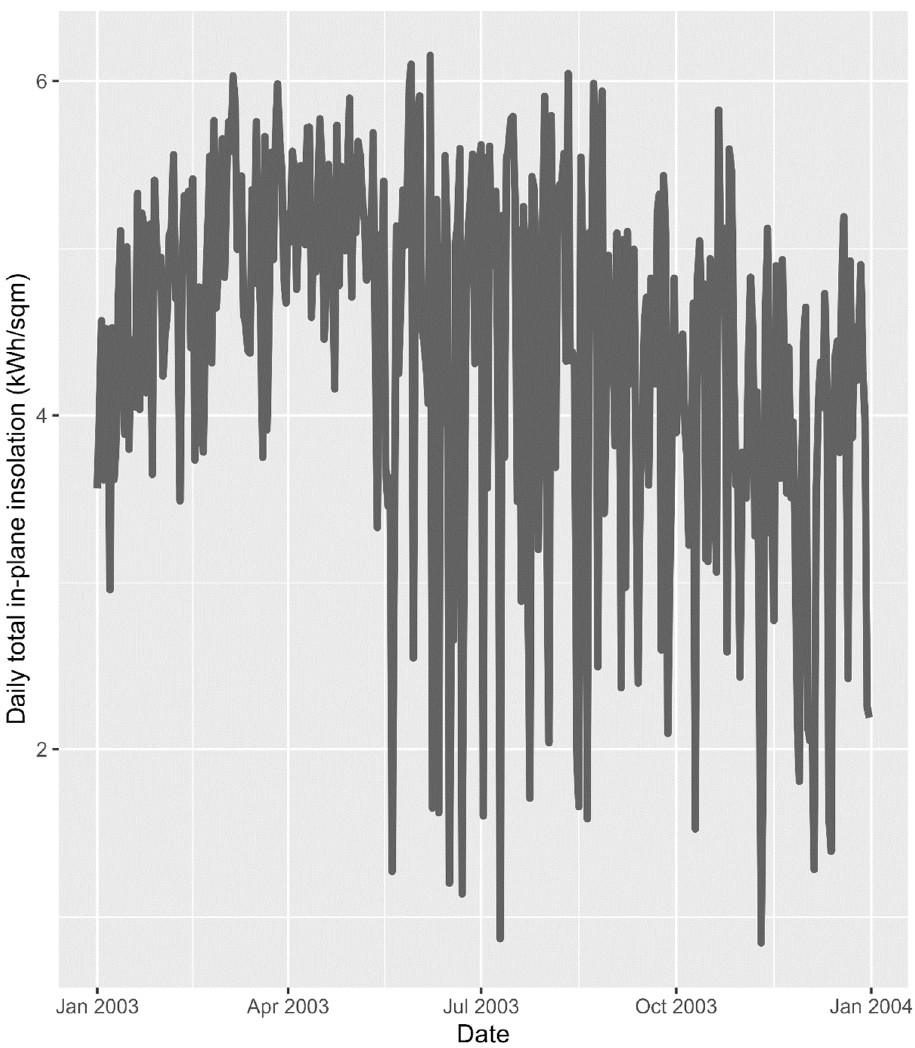
Figure 3. Daily total insolation on a horizontal plane for 2003, Piarco Trinidad and Tobago.